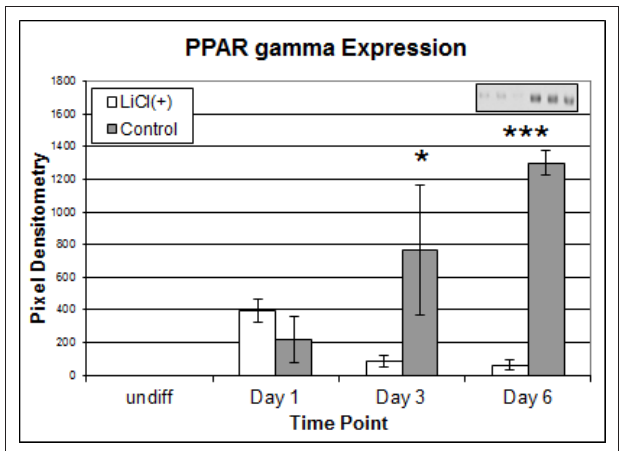
Figure 4 | Effect of LiCl treatment on PPAR γ expression. Expression of PPAR γ protein following various time points of adipogenic differentiation ( n = 3). Inset image representative of western blot raw data. Error bars represent